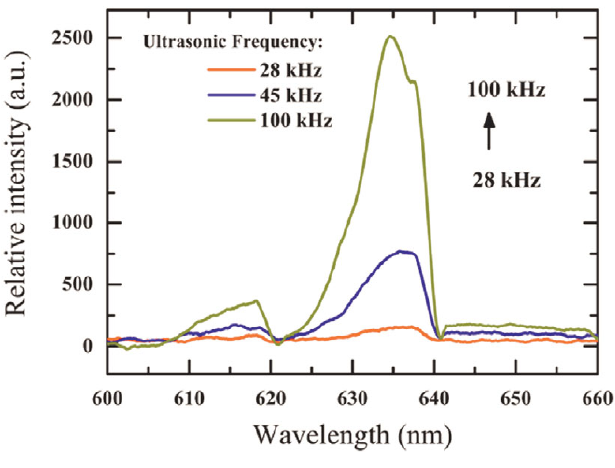
Figure 4. The mechano-luminescent output spectrograph of the composite under frequencies of 28 kHz, 45 kHz and 100 kHz,